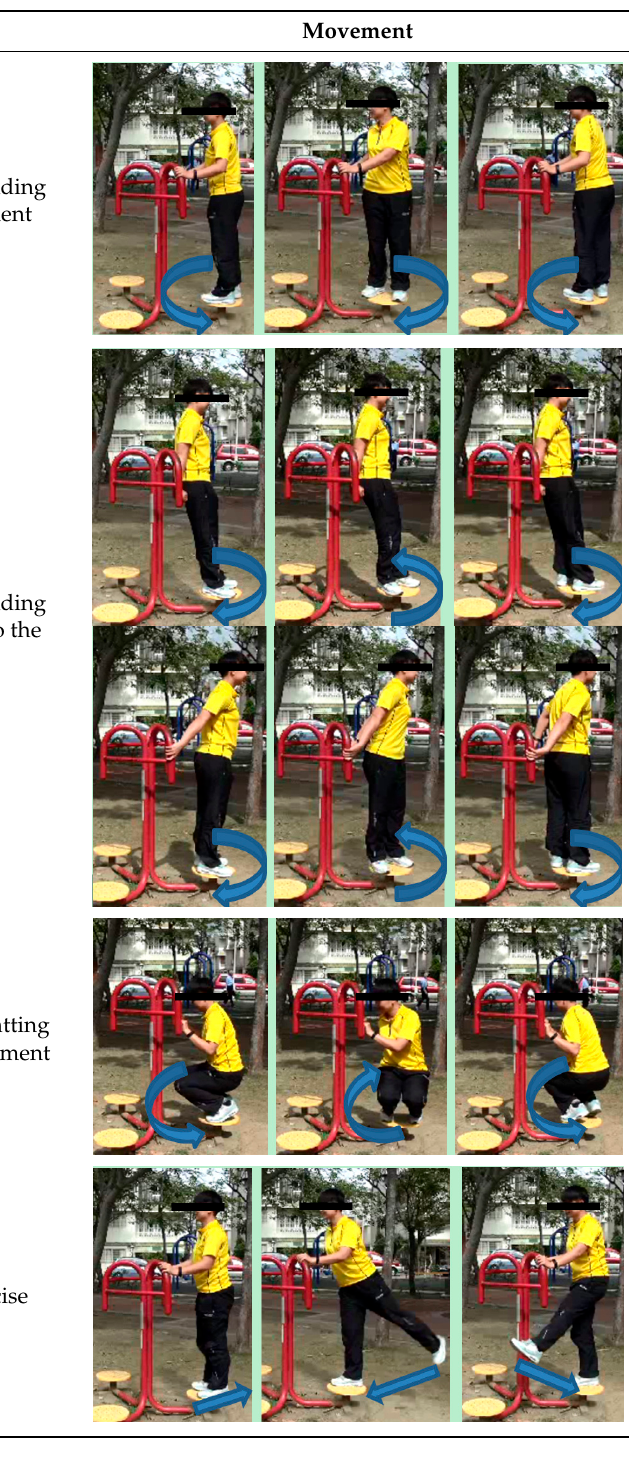
Table A1. Depictions of user behaviors for the triple waist